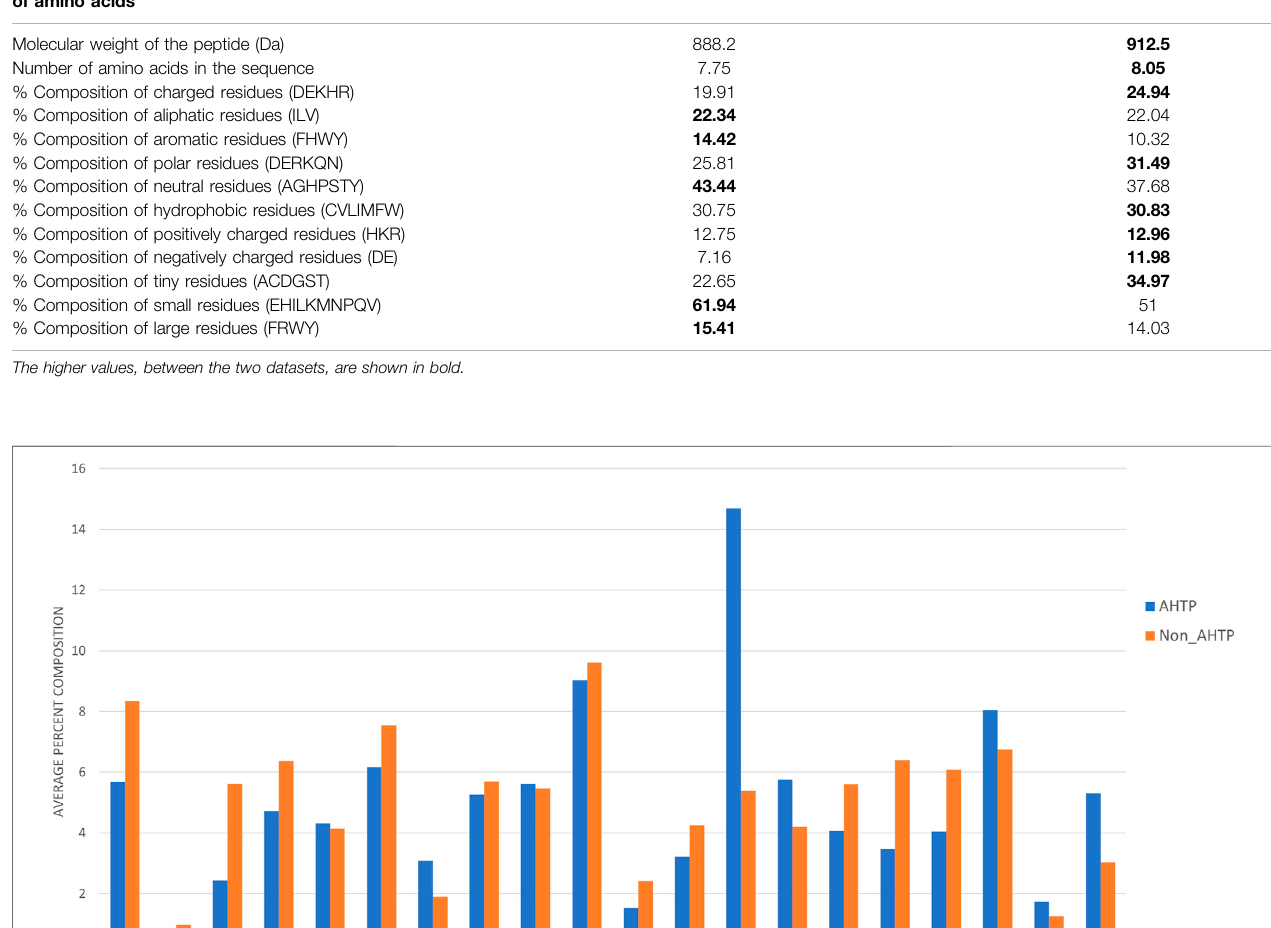
TABLE 1 | Physicochemical property-based composition of amino acids. Physicochemical property-based composition of amino acids